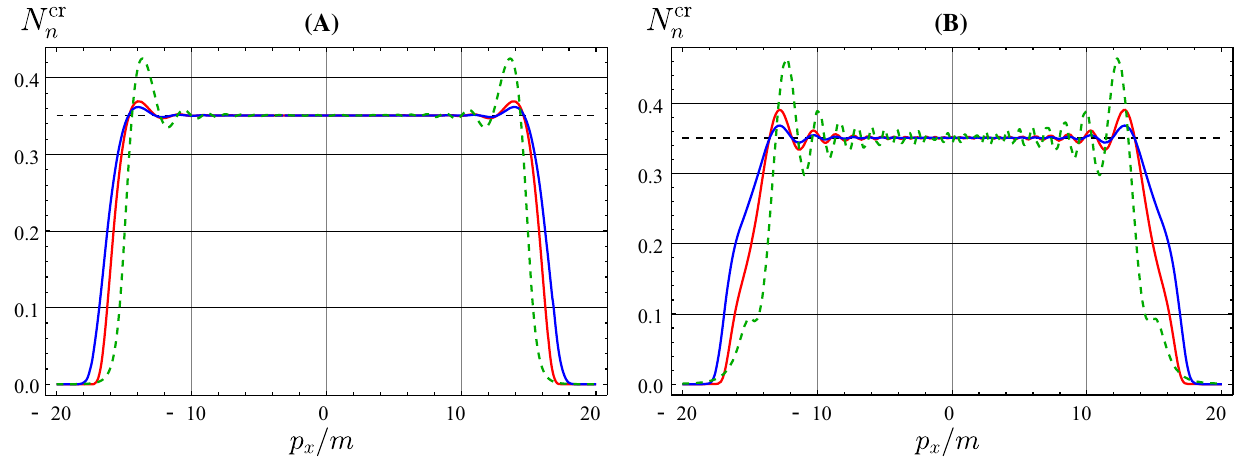
Fig. 9 Differential mean number of Fermions ( a ) and Bosons ( b ) created from the vacuum by electric fields. The solid red and blue lines refers to the composite fields (51) and (62), respectively, with τ = τ = τ and k = k = k . The dashed green lines refers to the 1 2 1 2